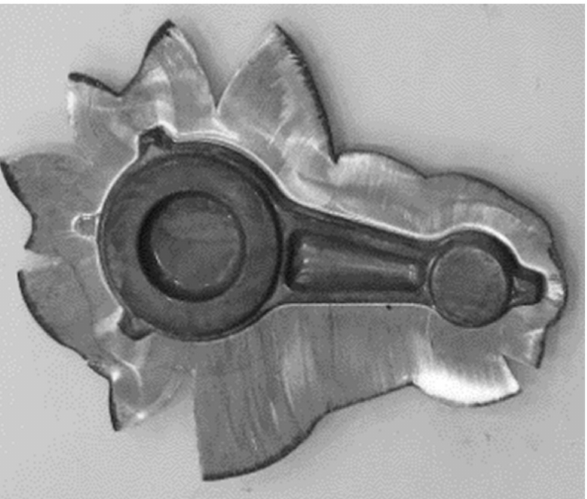
Figure 25. Forgings of connecting rods made of AB-71100 aluminum alloy obtained in the process of forging on a screw press from cast preforms in accordance with variant